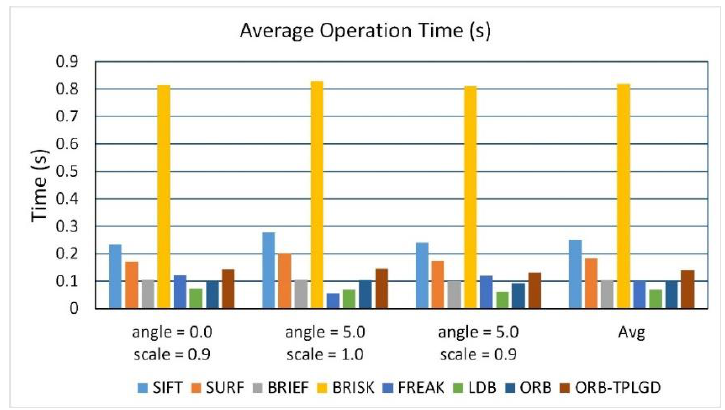
Figure 14. Average time required of test algorithms in the case of these three image transformations.